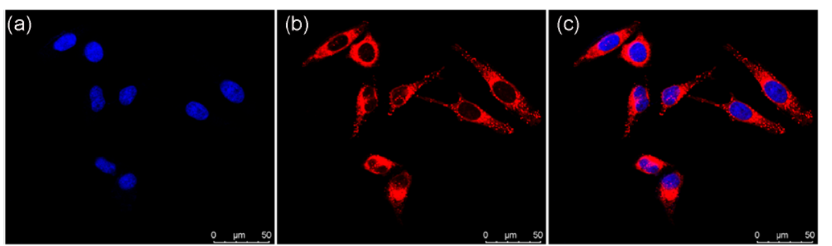
Figure 2. Confocal fluorescence images of HeLa cells stained with BODIPY 1 and DAPI. ( a ) DAPI fluorescence, ( b ) BODIPY 1 fluorescence, and ( c ) merged image. Adapted from [19].